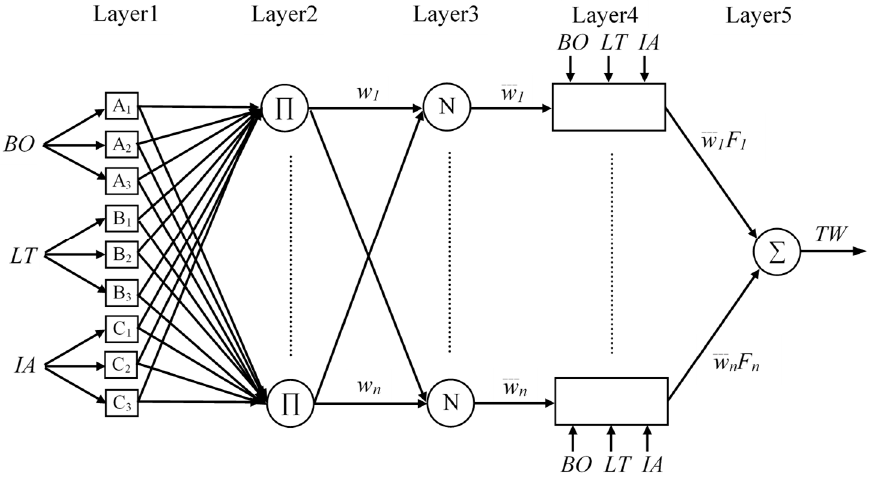
Figure 6. ANFIS architecture for three input Sugeno fuzzy model.